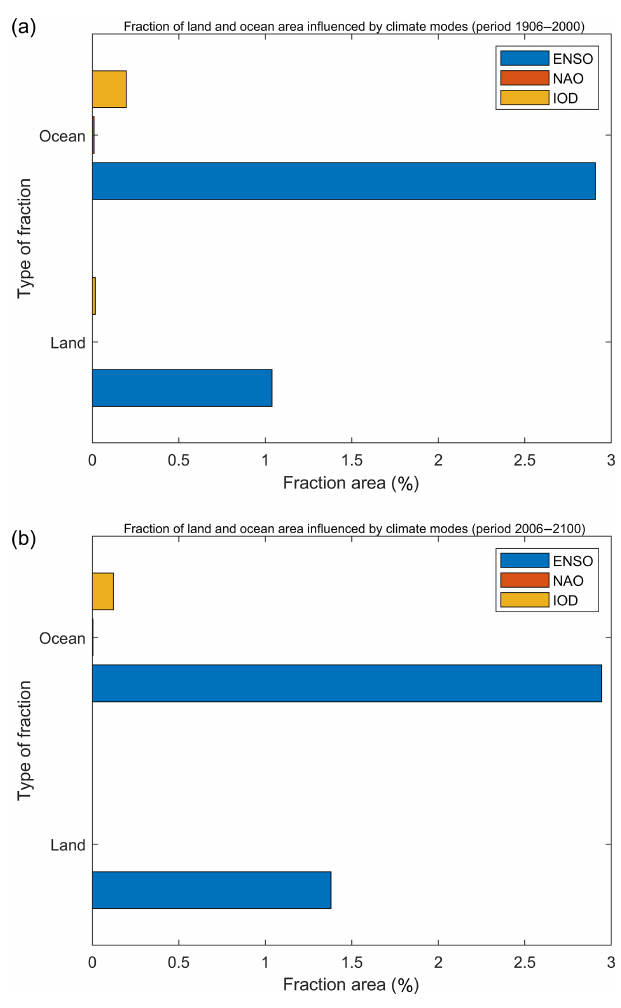
Figure 5. Fraction of Earth surface for land and ocean with the probability for the absence of Granger causality between climate modes and evaporation less than 0.1 (i.e., p value < 0 . 1). The re- sults are shown for the influence of an individual climate mode on annual mean evaporation for the periods 1906–2000 (a) and 2006– 2100 (b) . Fraction areas influenced by ENSO, NAO and the IOD are shown in blue, red and yellow bars, respectively. Several frac- tion areas are close to zero. ENSO: El Niño–Southern Oscillation. NAO: North Atlantic Oscillation. IOD: Indian Ocean